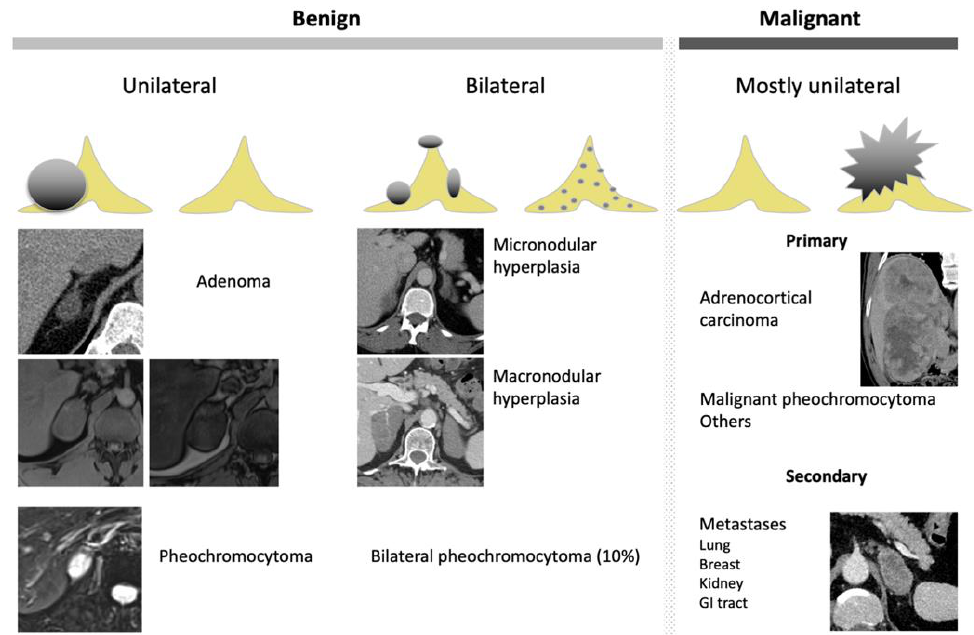
Figure 4. Graphical summary of benign and malignant adrenal incidentaloma on CT and MRI. GI, gastrointestinal.